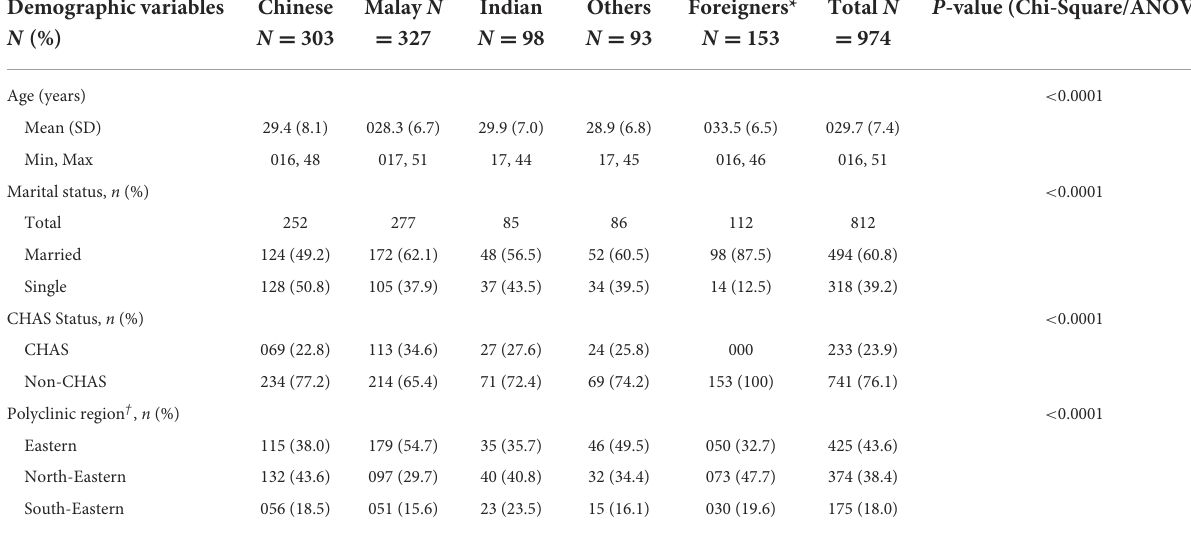
TABLE 3 Sub-analyses of ethnicities of women requesting referrals for unintended pregnancies. Demographic